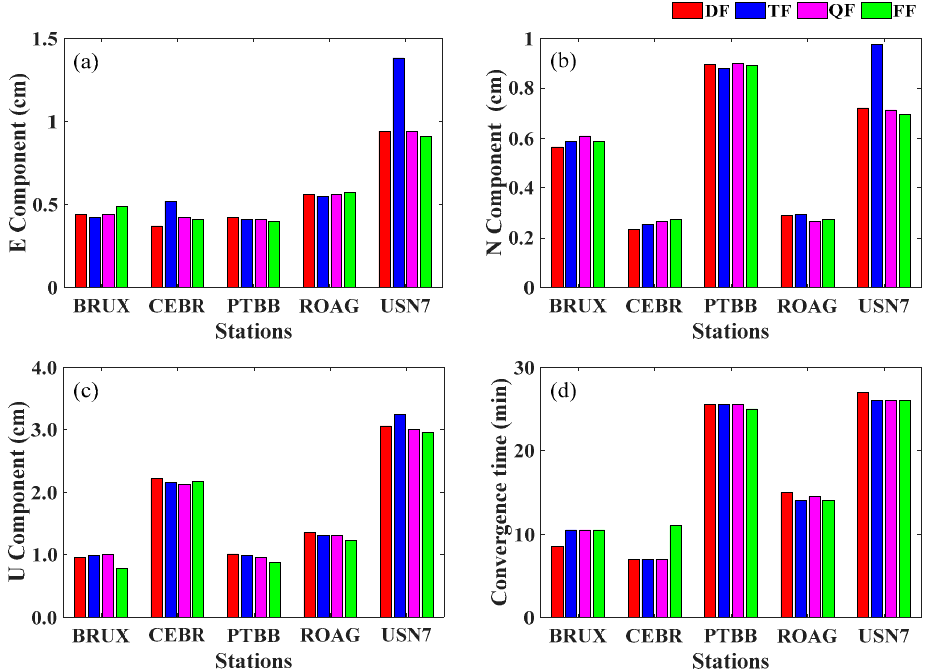
Figure 5. Positioning performance of BRUX, CEBR, PTBB, ROAG and USN7 stations for the DF, TF, QF and FF1 PPP models on DOYs 190 to 196 in 2020. ( a ) E component RMS value; ( b ) N component RMS value; ( c ) U component RMS value; and ( d ) convergence time.